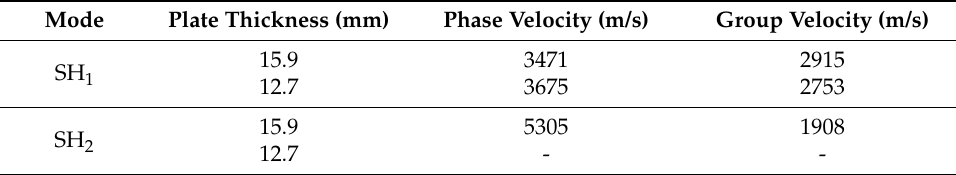
Table 2. Comparison of wave speeds for 250 kHz excitation frequency.